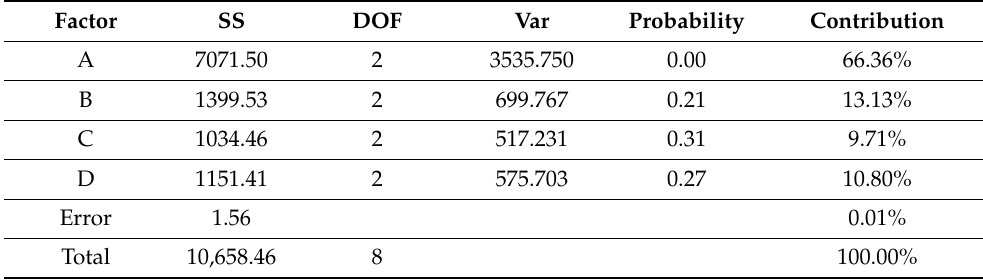
Figure 9. Main effect plot of S/N ratios at various peeling widths. Table 7. ANOVA results at various peeling widths.